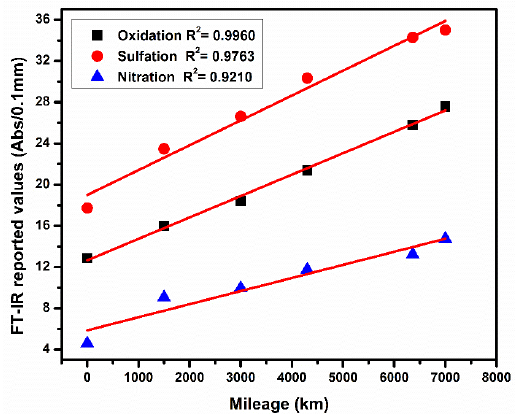
Figure 6. Evolution of lubricant oil degradation parameters plotted as function of mileage. Red lines represent linear fits of the experimental data, coefficients of determination ( R 2 ) for each degradation parameter are showed in the inset.